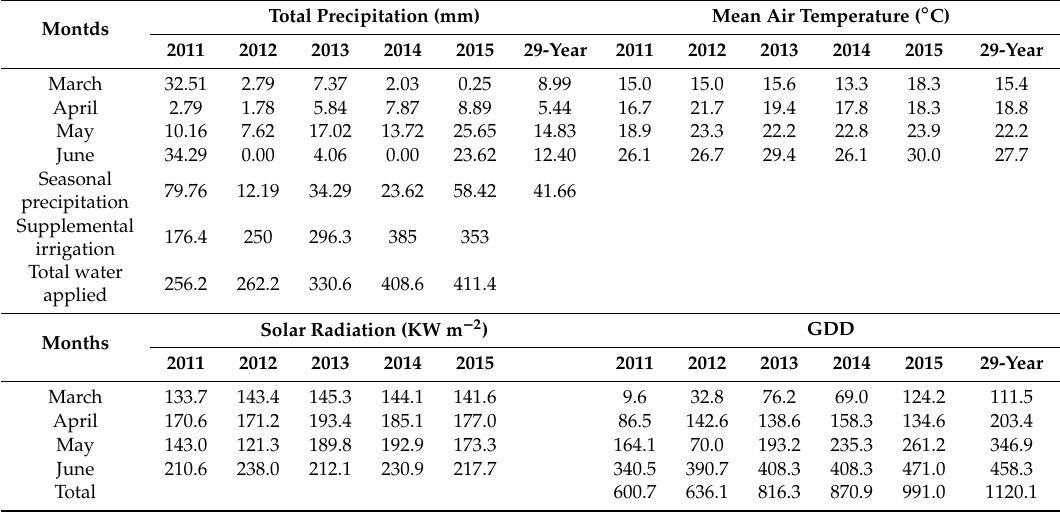
Table 1. Monthly accumulated precipitation, mean air temperature, accumulated solar radiation, and growing degree-days (GDD) at the University of Nevada, Reno Valley Road Field Laboratory Reno, NV during the 2011 to 2015 growing seasons and the 29-year average (1987–2015).